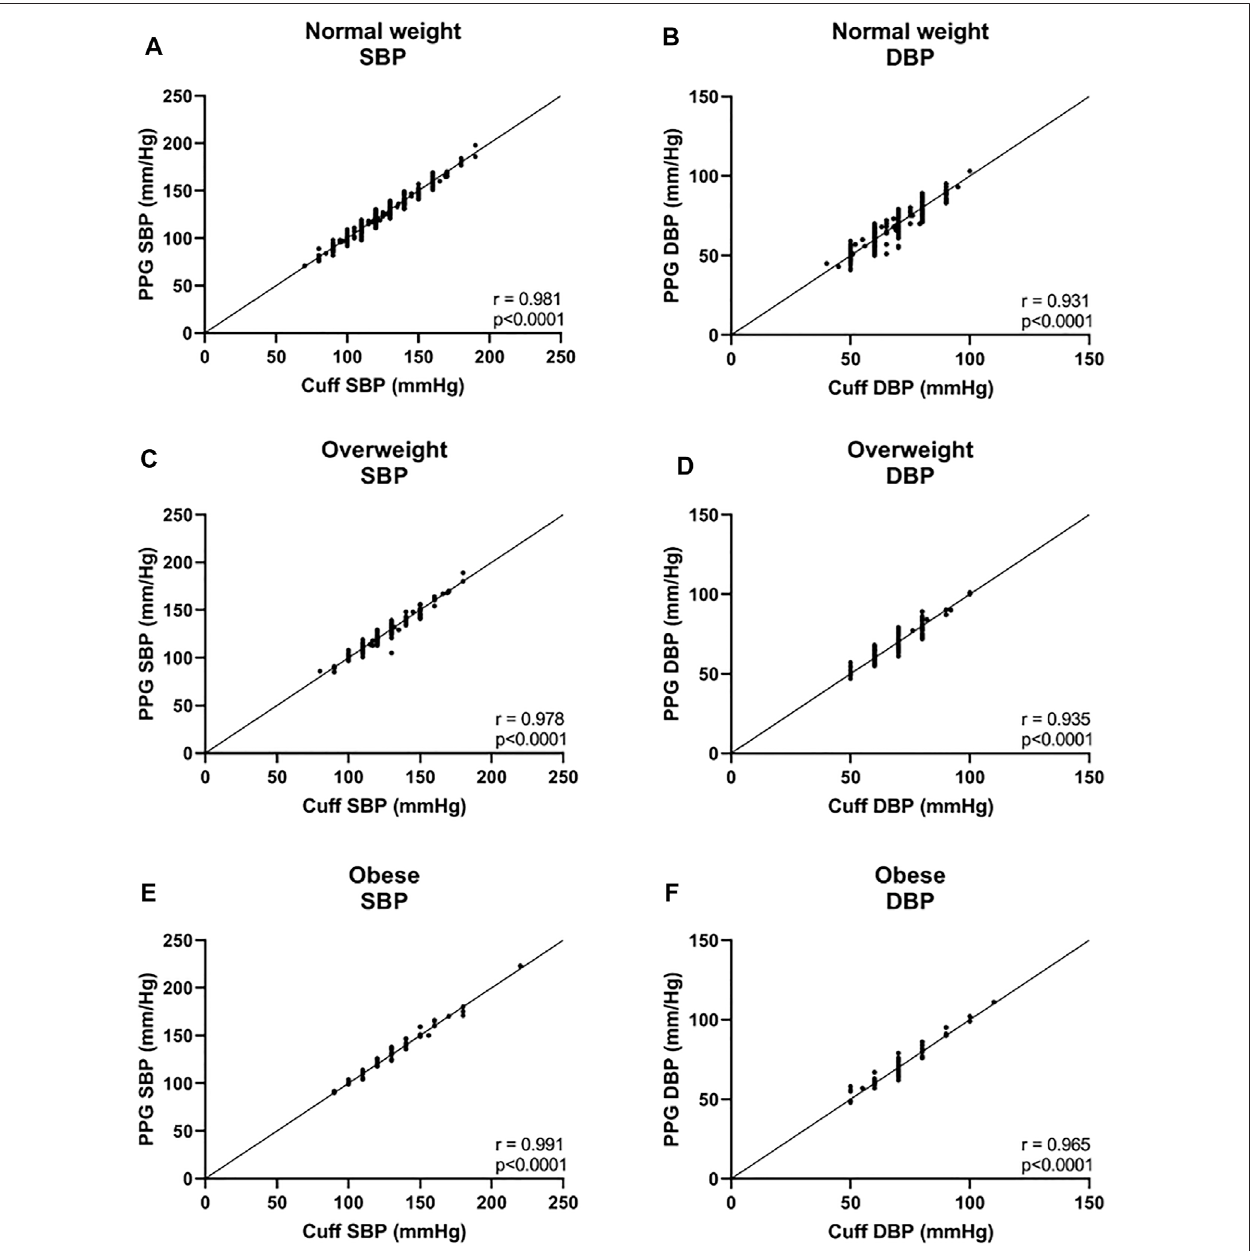
FIGURE4| Correlationcurves ofthebody massindex (BMI)groups. Normalweight wasde fi nedasBMI < 25, overweight wasde fi ned as25 ≤ BMI < 30,and obese was de fi ned as 30 ≤ BMI. SBP systolic blood pressure, DBP diastolic blood pressure.